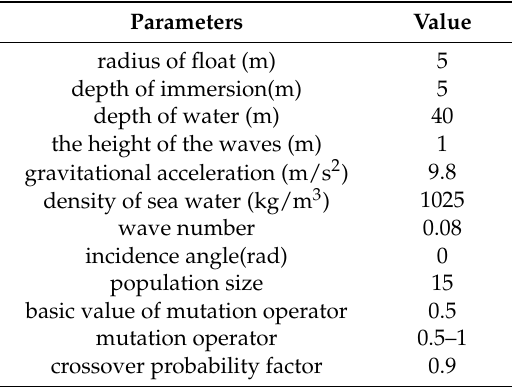
Table 1. Parameters of the float and the WEC